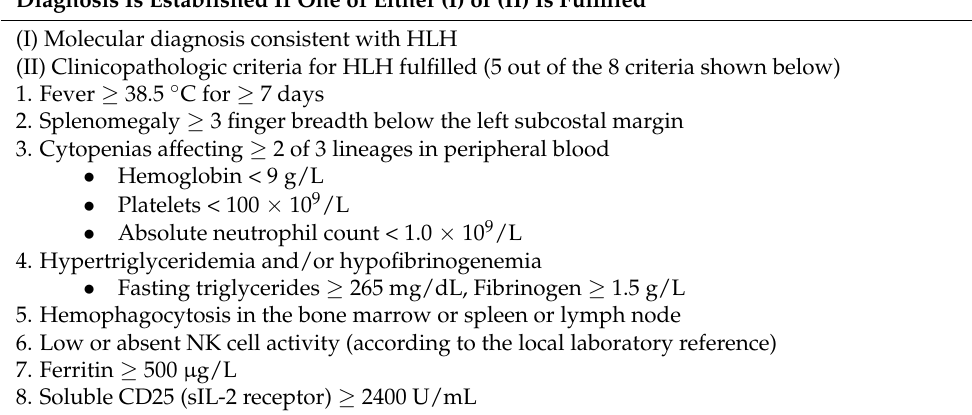
Table 1. Diagnostic criteria of hemophagocytic lymphohistiocytosis. Adapted from the standard diagnostic criteria proposed in 2004 by Henter et al. HLH-2004